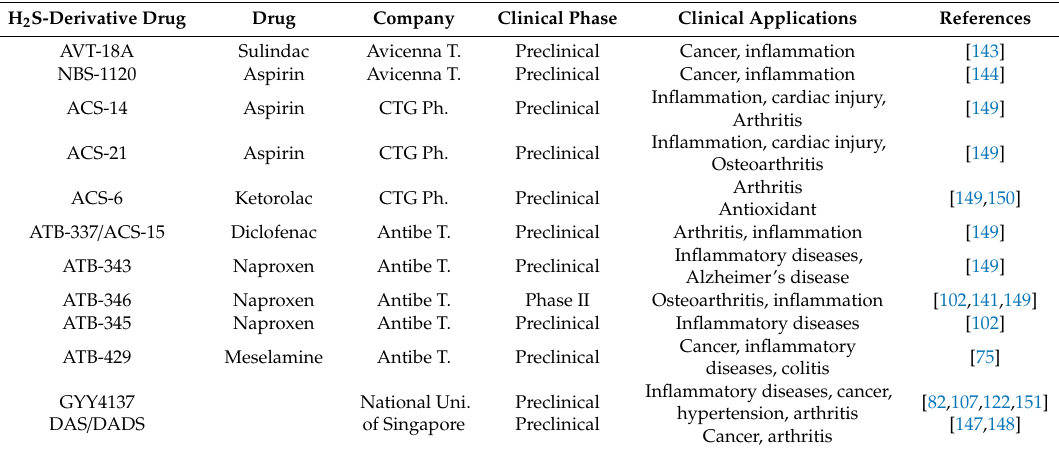
Table 1. H 2 S-releasing drugs as potential anti-inflammatory drugs in arthritis. H 2 S-Derivative